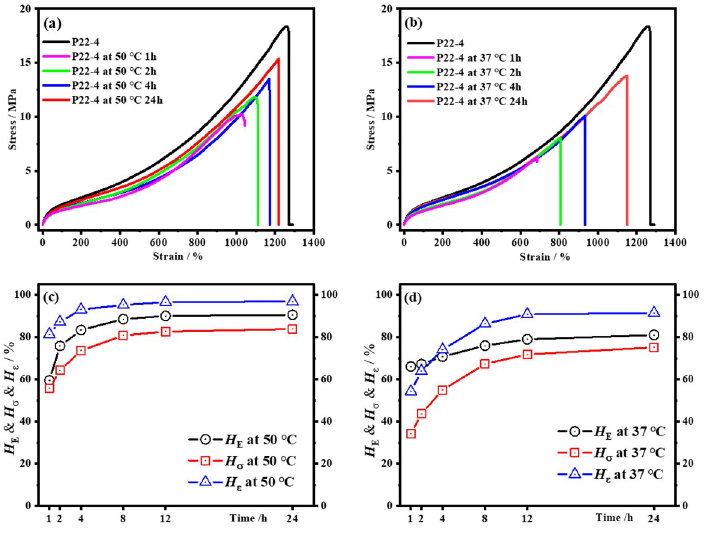
Figure 8. The typical tensile curves of the healed P22-4 sample at different healing times at 50 ( a ) and 37 °C ( b ). The healing efficiency of the Young modulus (H E ), ultimate tensile strength (H σ ) and elongation at break (H ε ) with healing times at 50 ( c ) and 37 °C ( d ).